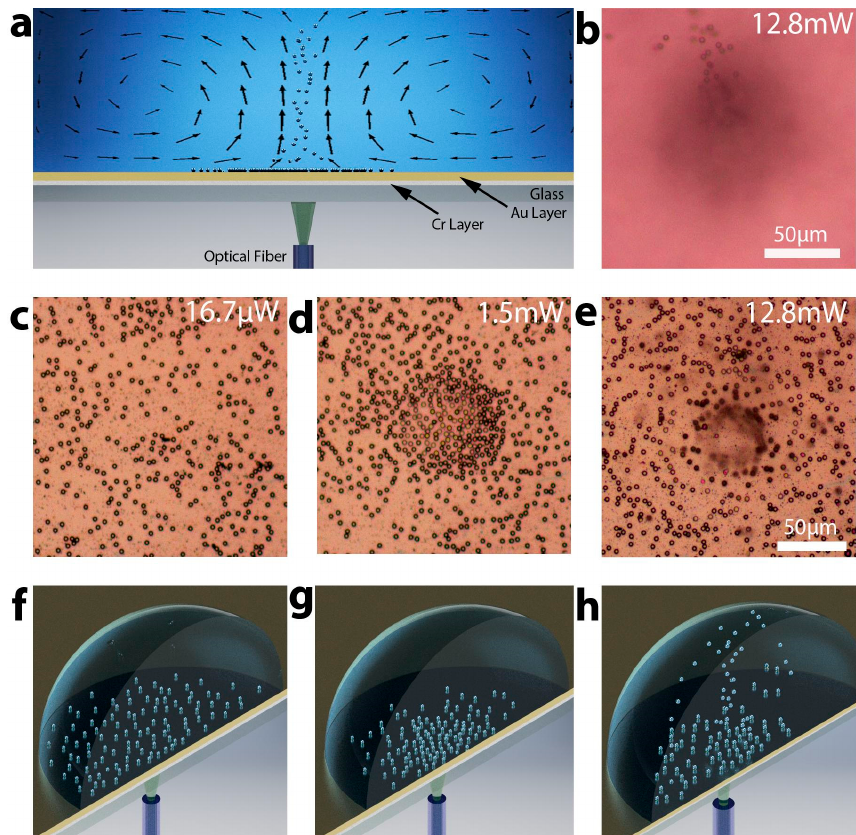
Figure 1. Explanation of opto-fluidic manipulation. ( a ) A 2-D model showing the trapping and levitation of particles using the convective vortices generated by the laser excitation. The arrows show fluid velocity vectors, and the thickness of arrows corresponds to the speed of movement. ( b ) Optical microscope image showing stream of 5 µm polystyrene beads levitated by opto-fluidics. ( c–h ) Optical microscope images and corresponding three-dimensional models of the three regimes of opto-fluidic particle manipulation; ( c , f ) low power—no controllable particle movement; ( d , g ) medium power— trapping regime; ( e , h ) high power—levitation regime. In ( e ) the spot in the center looks out of focus because in that area particles are projected upwards.